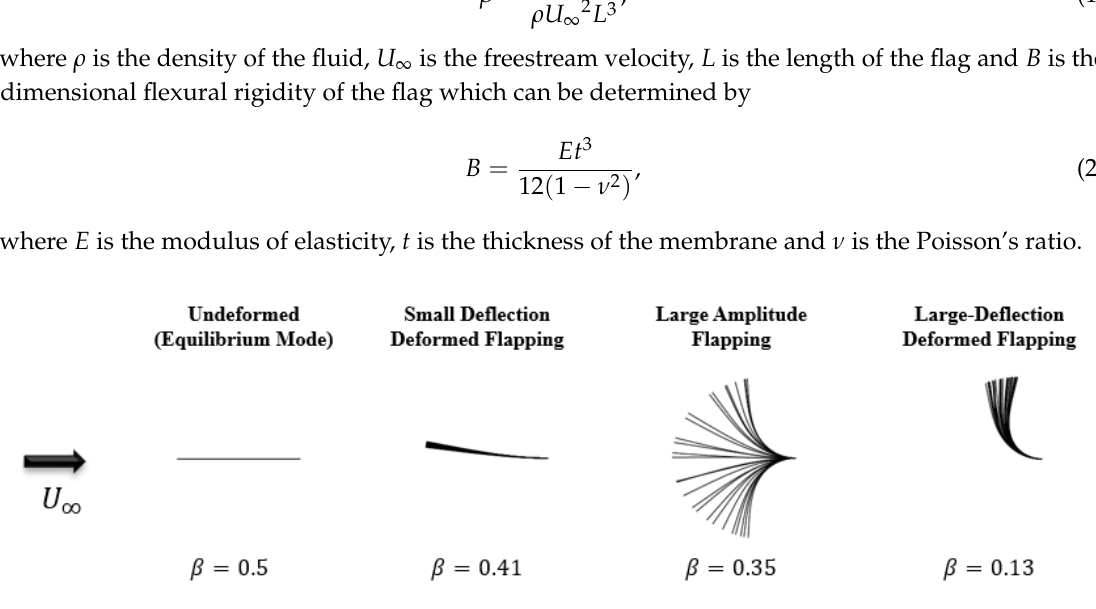
Figure 5. A time lapse of the flag position of an inverted flag for different non-dimensional stiffness ( β ) at a Reynolds number of 200 [17].